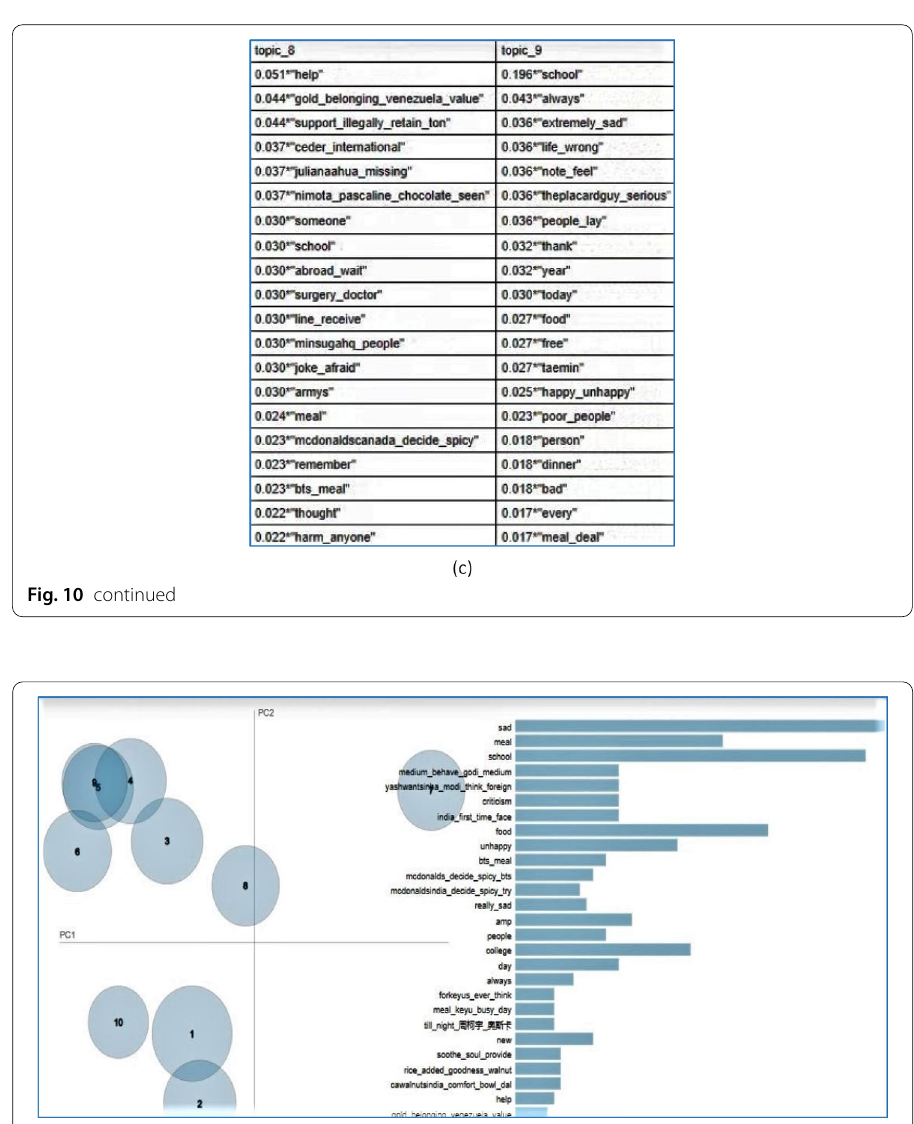
Fig. 11 Representation of the top salient terms in the